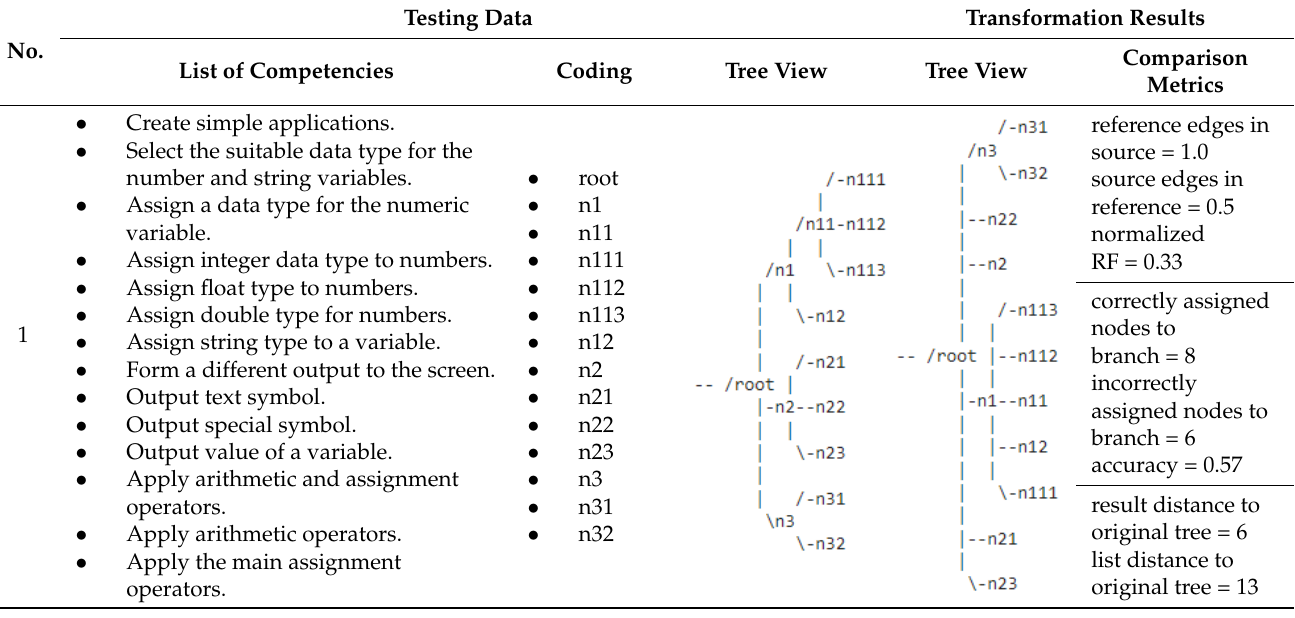
Table A1. Summary of all test cases and competency list transformation to tree results.